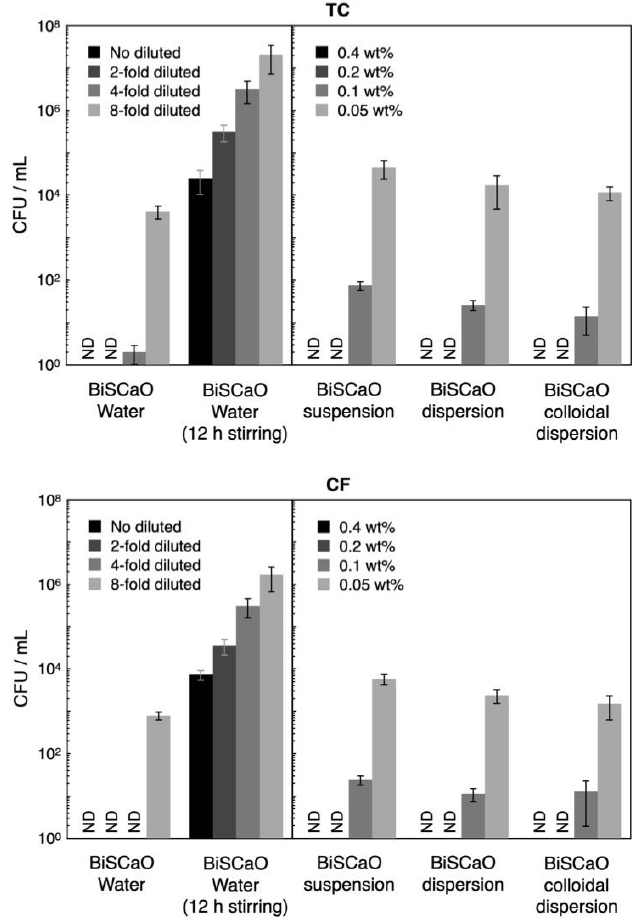
Figure 6. Microbicidal efficacy of test samples against contaminated suspension. The CFU/mL for total viable bacterial cells (TC) and coliform bacteria (CF) following treatment for 15 min with undiluted and two-fold diluted BiSCaO Water and 0.4 and 0.2 wt.% of BiSCaO suspension, dispersion, and colloidal dispersion could completely sterilize (<10 CFU/mL), while about 10,000 CFU/mL of both TC and CF with 12h-stirred BiSCaO Water remained viable even with the no diluted test sample. Plating and counting were performed as a set of four technical replicates ( n = 4) and error bars represent means ± S.D. ND denotes not detected.